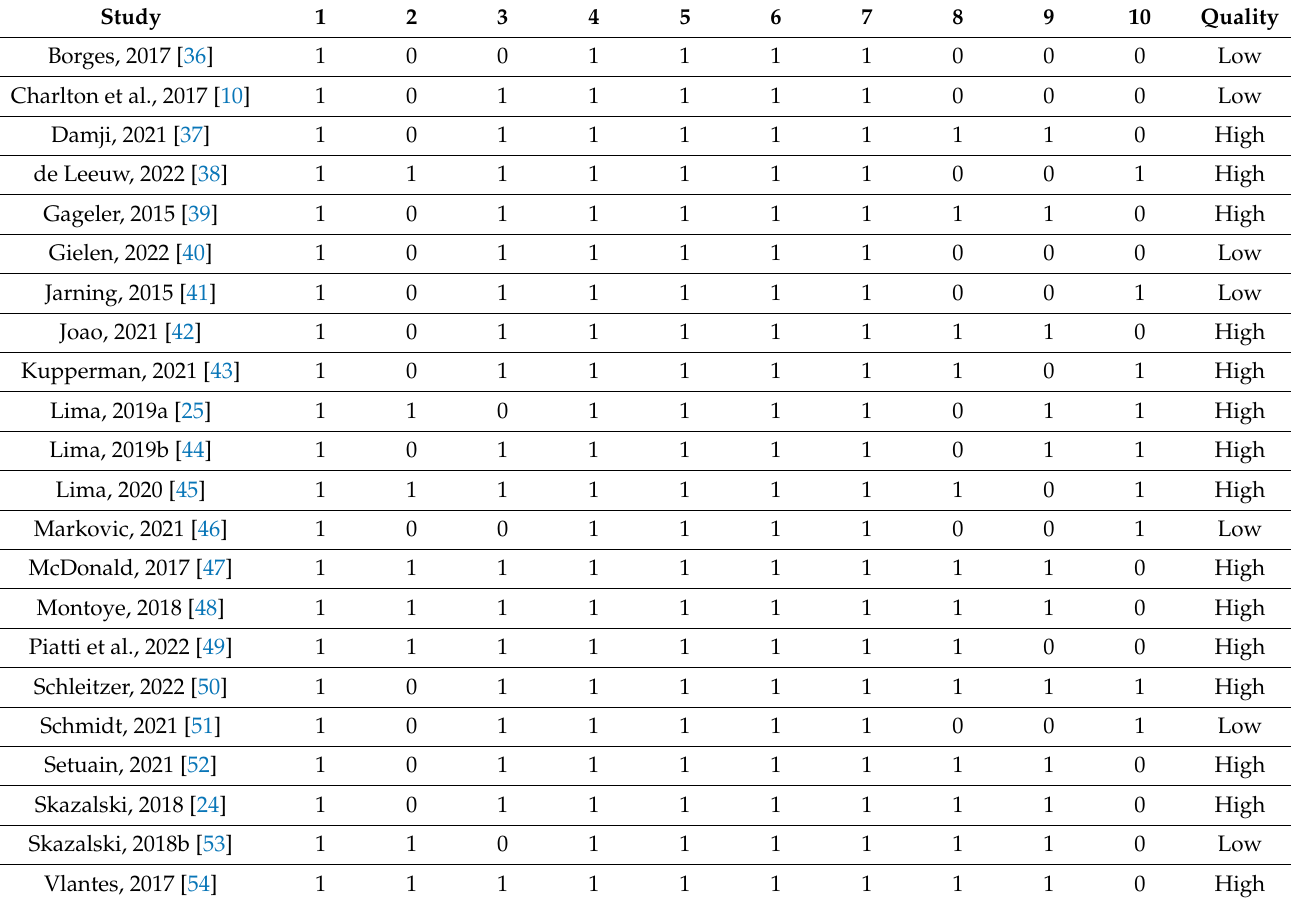
Table 1. Reporting risk of bias assessment of the included